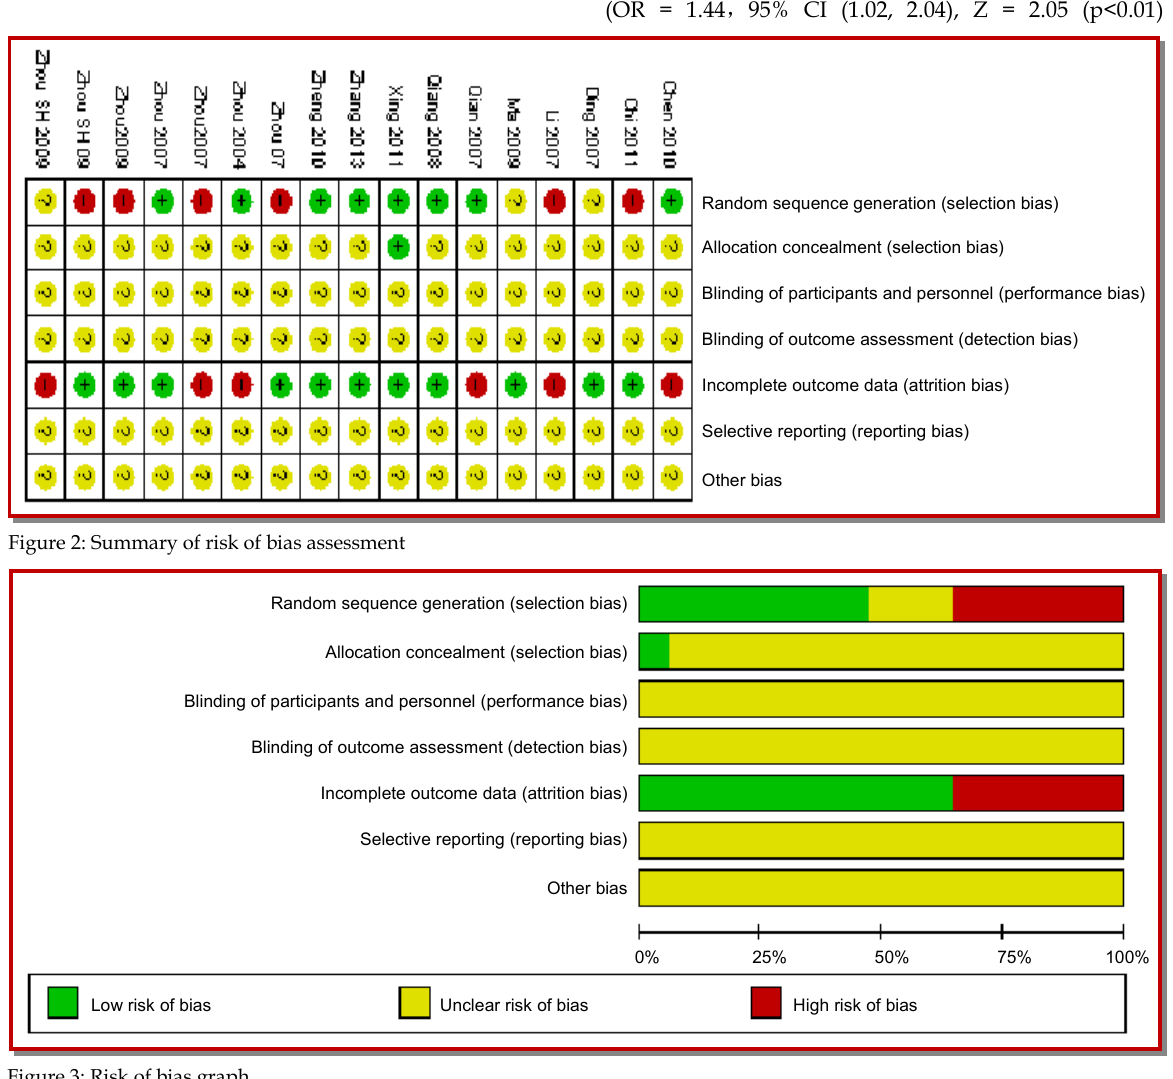
Figure 3: Risk of bias